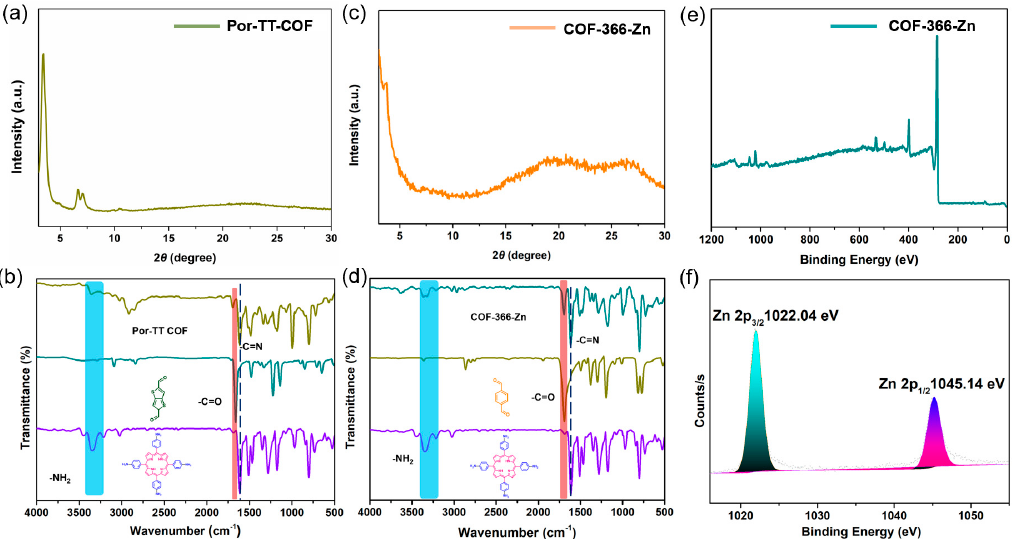
Figure 8. ( a ) PXRD pattern of Por-TT COF; ( b ) FT-IR spectra of Por-TT-COF (dark yellow), TT (cyan), TAPP (violet); ( c ) PXRD pattern of COF-366-Zn; ( d ) FT-IR spectra of COF-366-Zn (cyan), BDT (dark yellow), TAPP (violet); ( e ) XPS of COF-366-Zn; and ( f ) high-resolution XPS spectra of Zn.